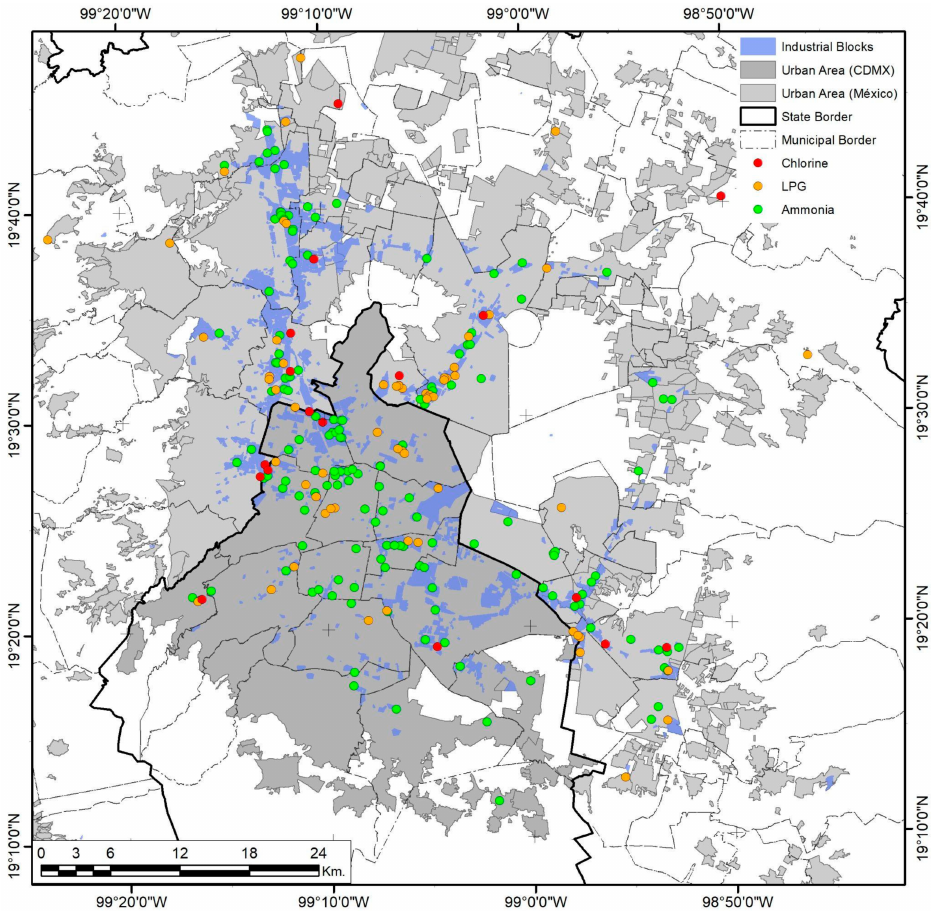
Figure 12. Mexico City urban area. The presence of industrial risks and their spatial relationship with industrial coverage. Developed by the authors with data from